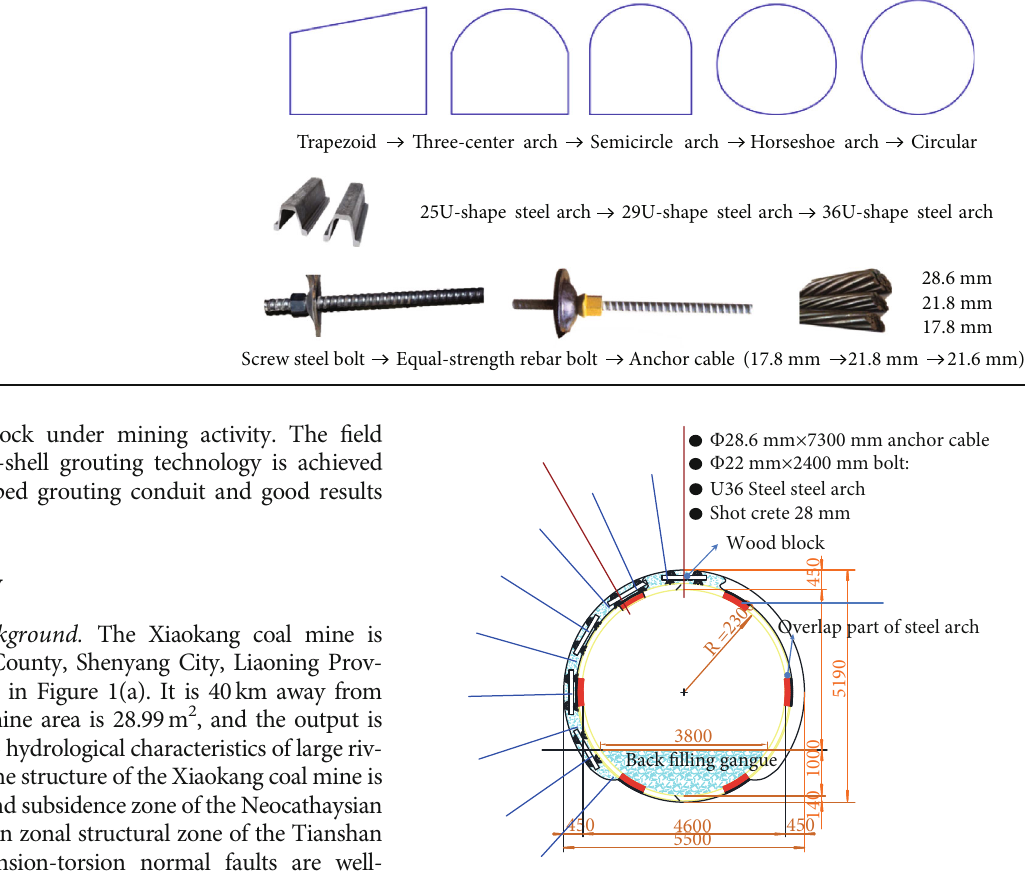
Figure 3: Support design of the ventilation roadway of